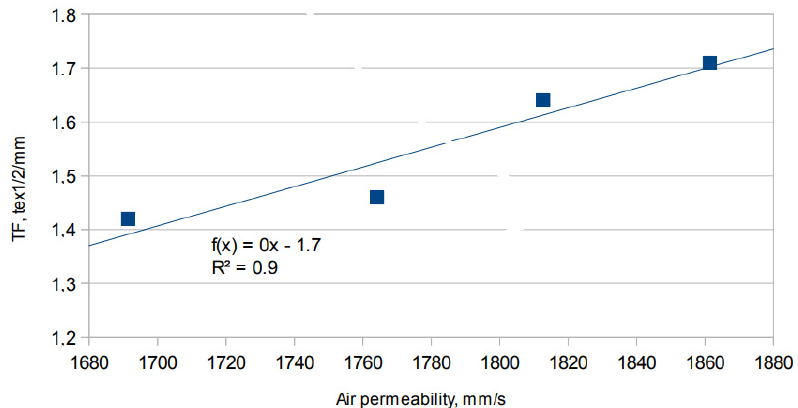
Figure 11. Relationship between air permeability and the tightness factor of the tested fabrics.